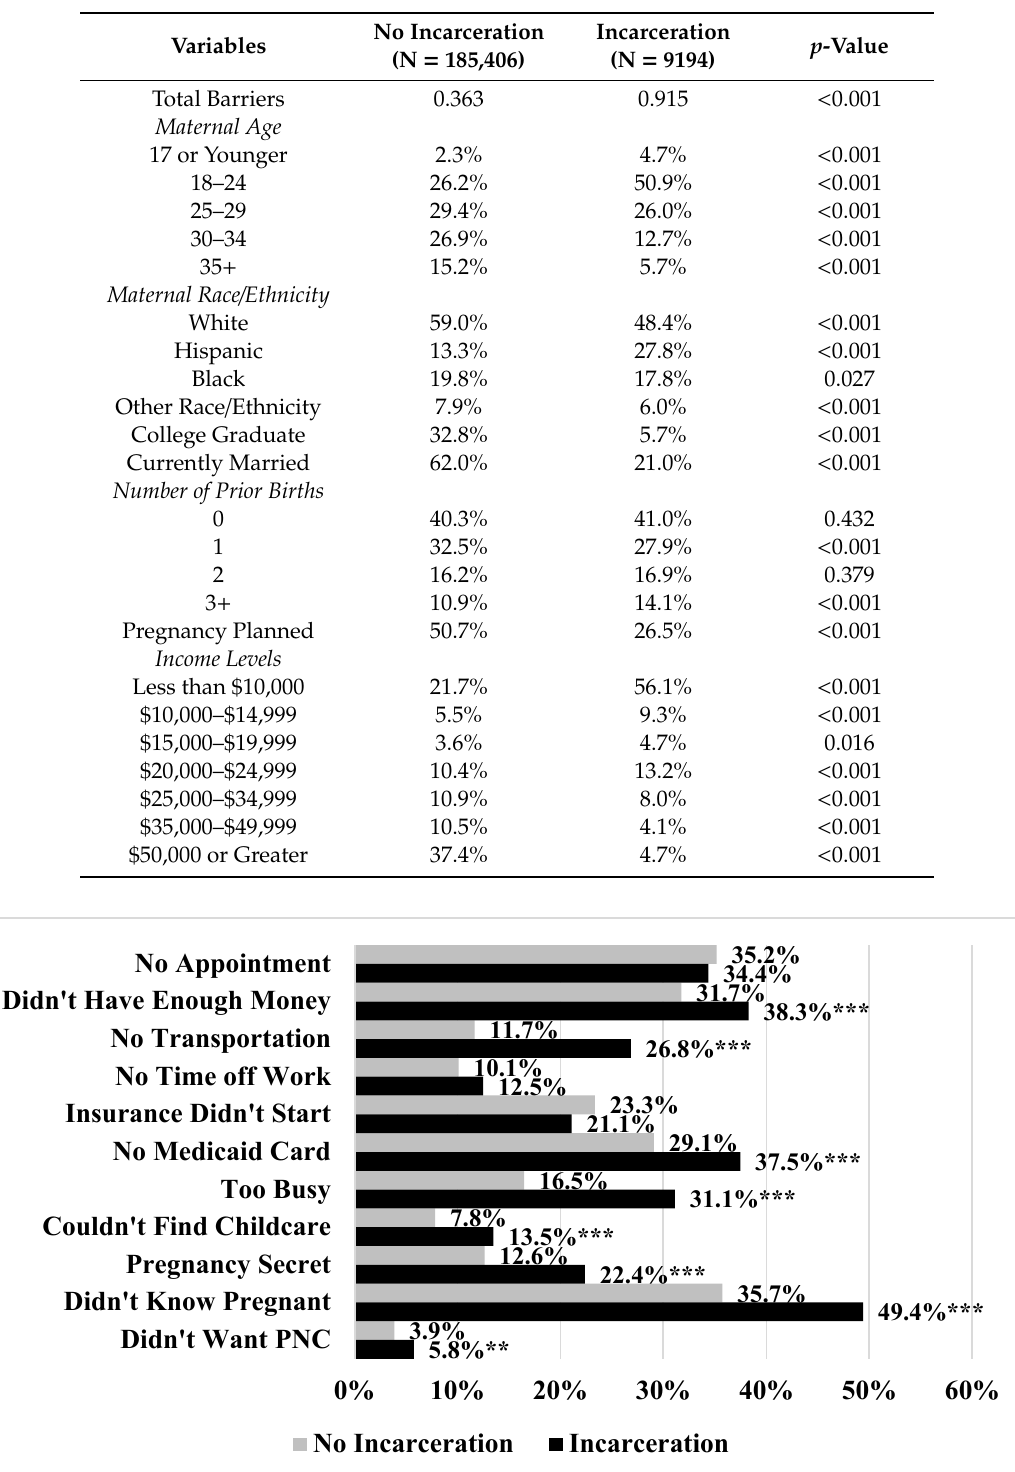
Table 1. Weighted Summary Statistics Stratified by Incarceration Exposure.